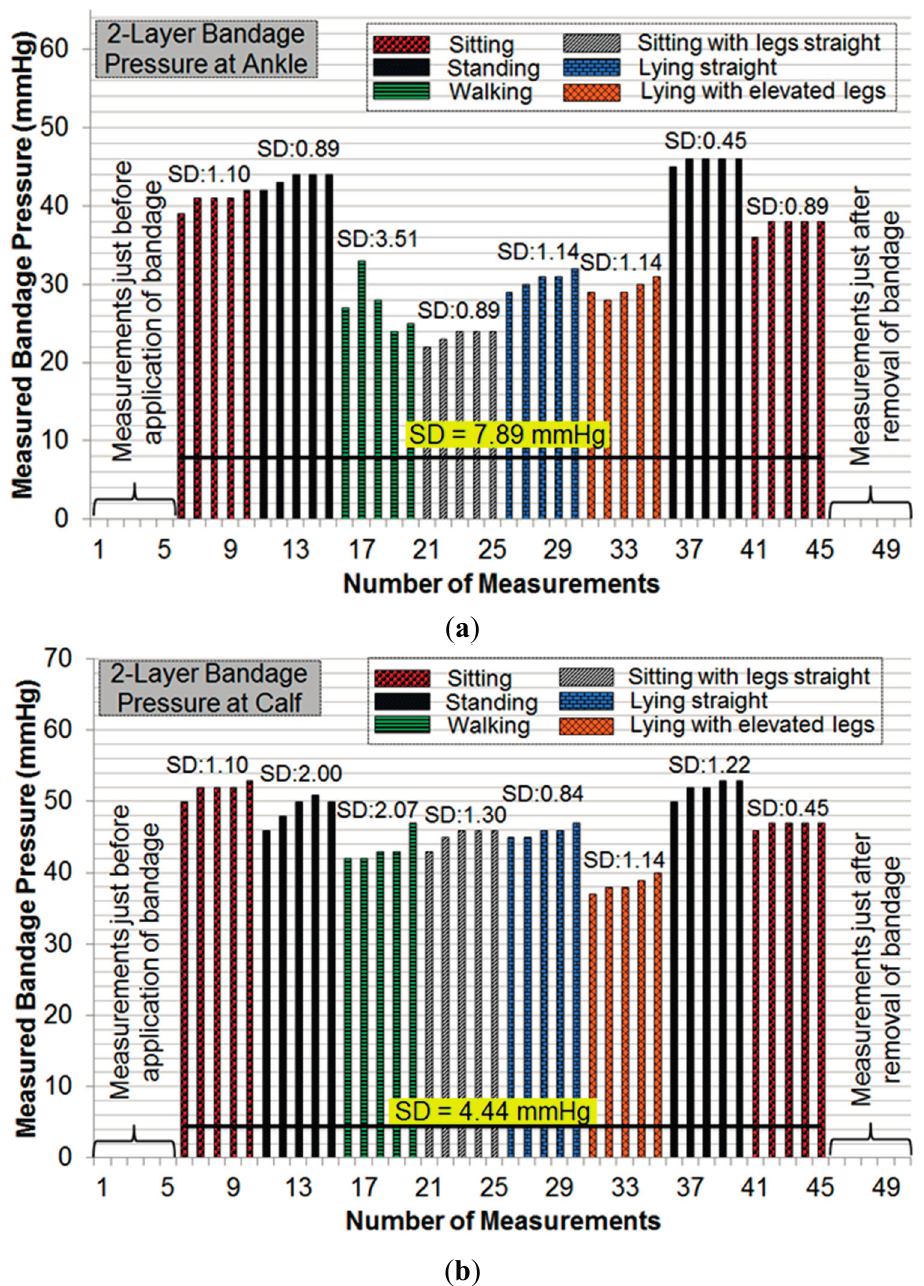
Figure 12. ( a ) Pressure measurements at the ankle with 2-layer bandage; ( b ) pressure measurements at the calf with 2-layer